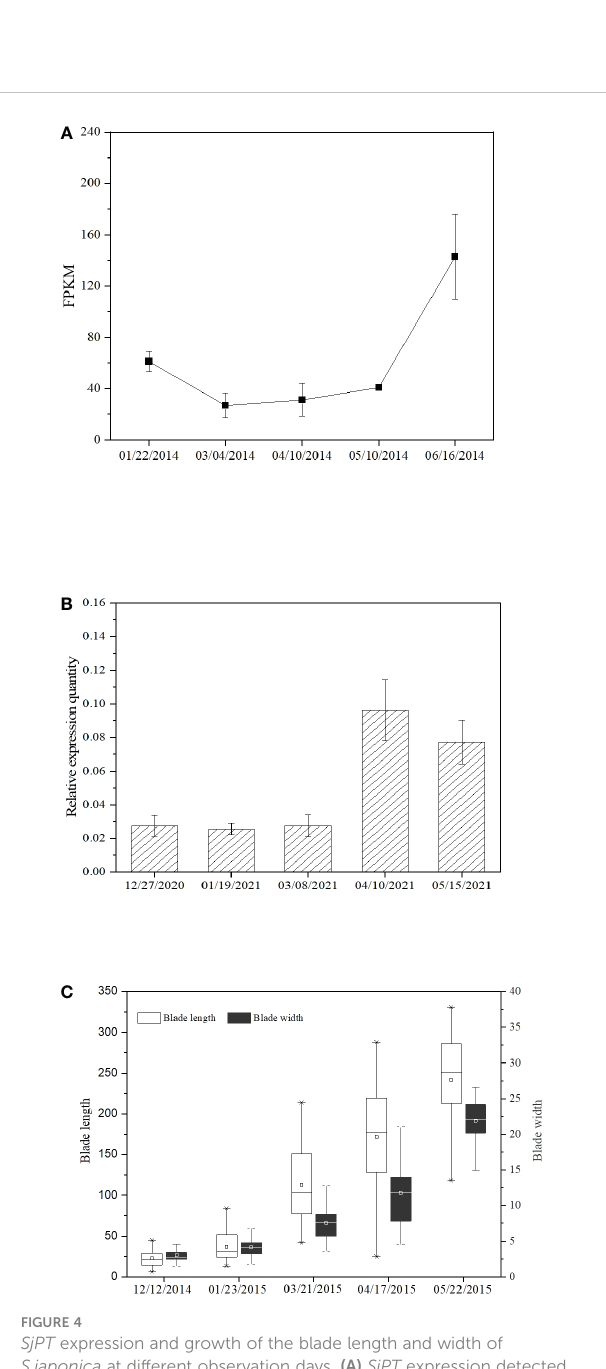
FIGURE 3 Phylogenetic relationship between SjPT and other homologues with bootstrap value